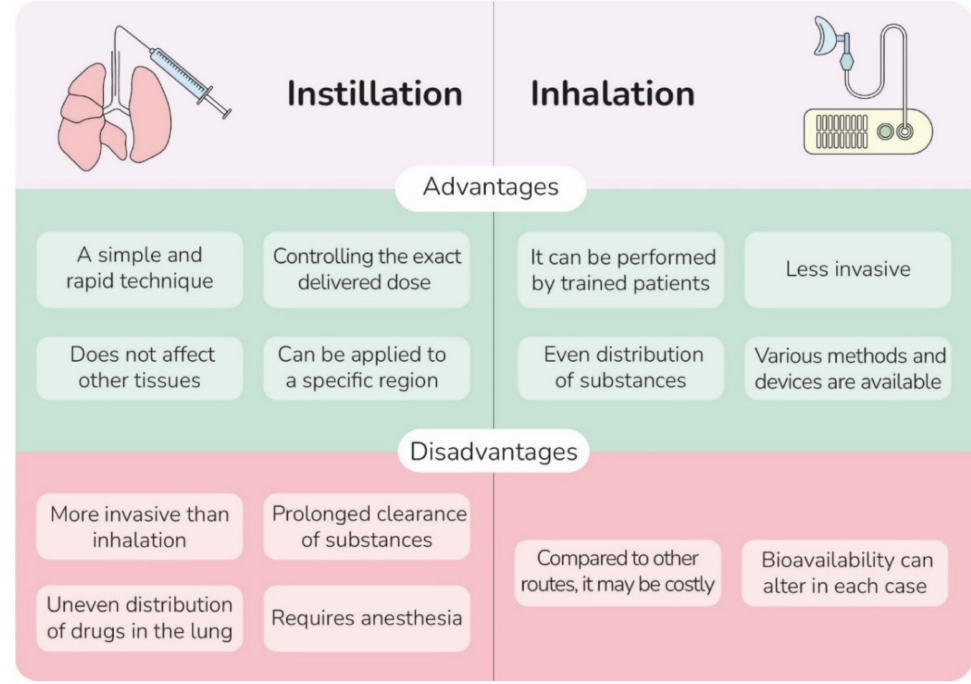
Figure 4. A comparison of advantages and disadvantages of intratracheal instillation and inhalation related to human